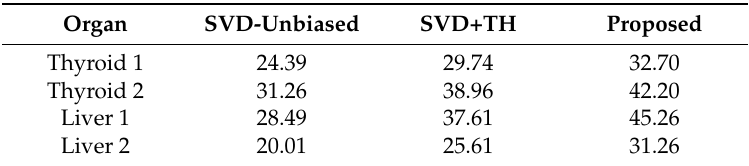
Table 5. CNR values (in dB) of microvessel images of two thyroid nodules and two liver cases using three different filtering methods.